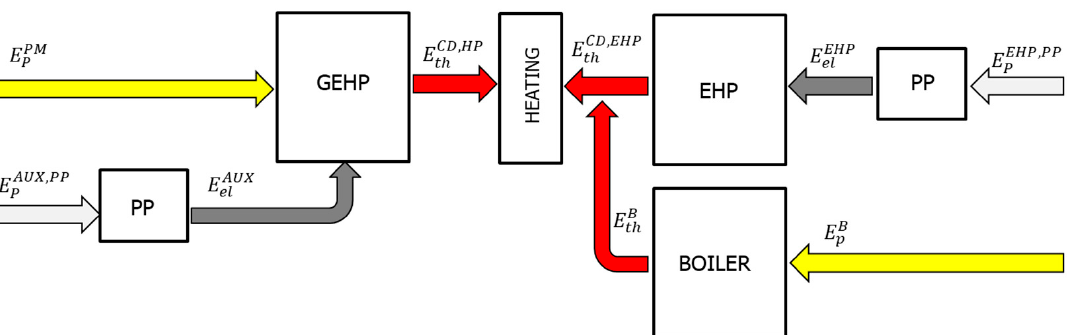
Figure 21. Comparison between GEHP-based and EHP/B-based systems.